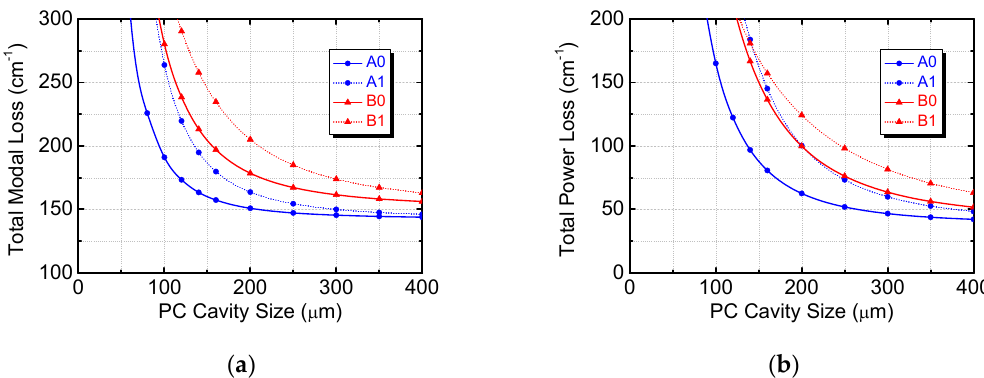
Figure 7. Finite cavity with RIT design ( f = 0.25): the total modal losses of the two lowest fundamental modes as well as associated first high-order modes as a function of PC cavity size for ( a ) air-hole and ( b ) air-pillar PC-SELs.